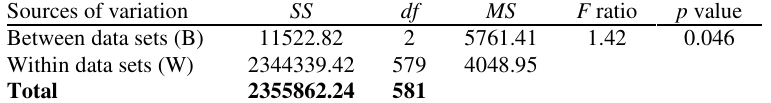
Table 1 Descriptive analysis of scores from the three aspects of climate change science Aspect x ̅ SD σ x ̅ Climate processes and causes of climate change 65.46 18.94 1.36 Climate change impacts